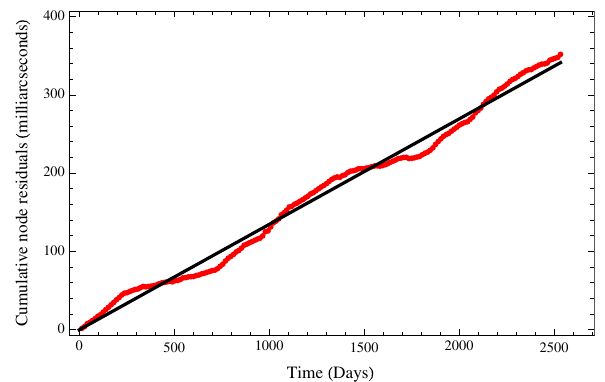
(Root Sum Squared) error is at the level of about 2%.